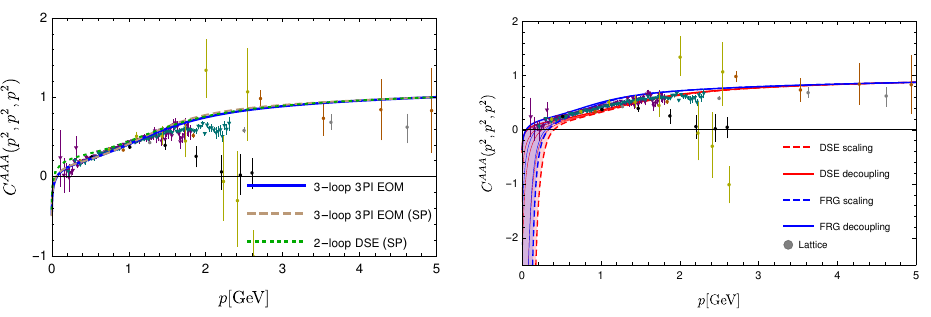
Figure 4. Left: Three-gluon vertex dressing function from the equation of motion of the 3PI e ff ective action with full and restricted kinematics (SP) and from the two-loop truncated DSE. Right: Three- gluon vertex dressing function at the symmetric point in comparison to FRG [31]. Lattice data from [43, 44].